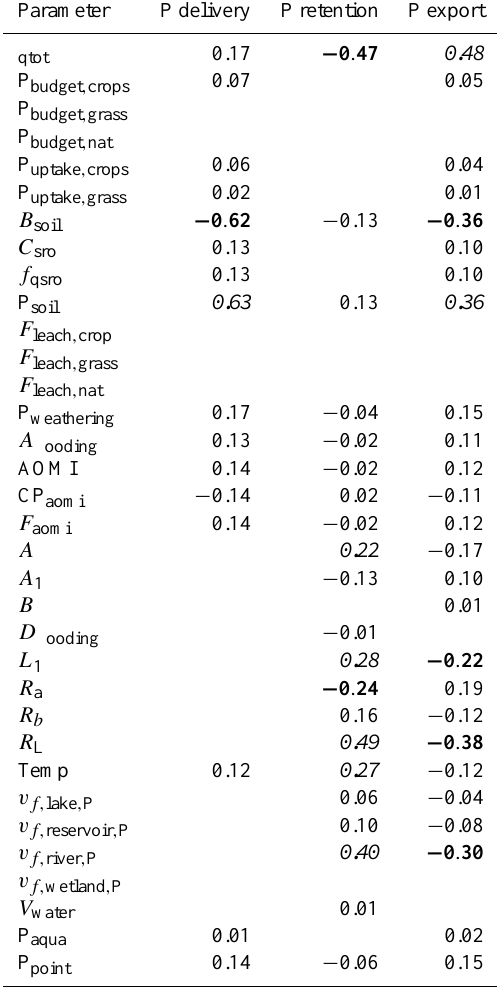
Table 5. Standardized regression coefficient (SRC) ∗ representing the relative sensitivity of N delivery, N retention and river N export representing global model results (columns) for the year 2000 to variation in 48 parameters.